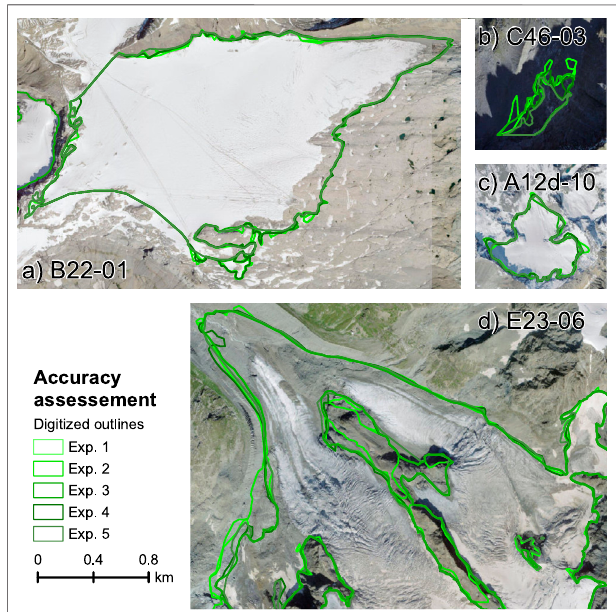
FIGURE 12 | Four examples of the digitization experiment for the accuracy assessment of the SGI2016 with outlines digitized by the fi ve experts. The background imagery corresponds to the SWISSIMAGE orthophotos used as source data for the compilation of glacier outlines and the codes represent the unique